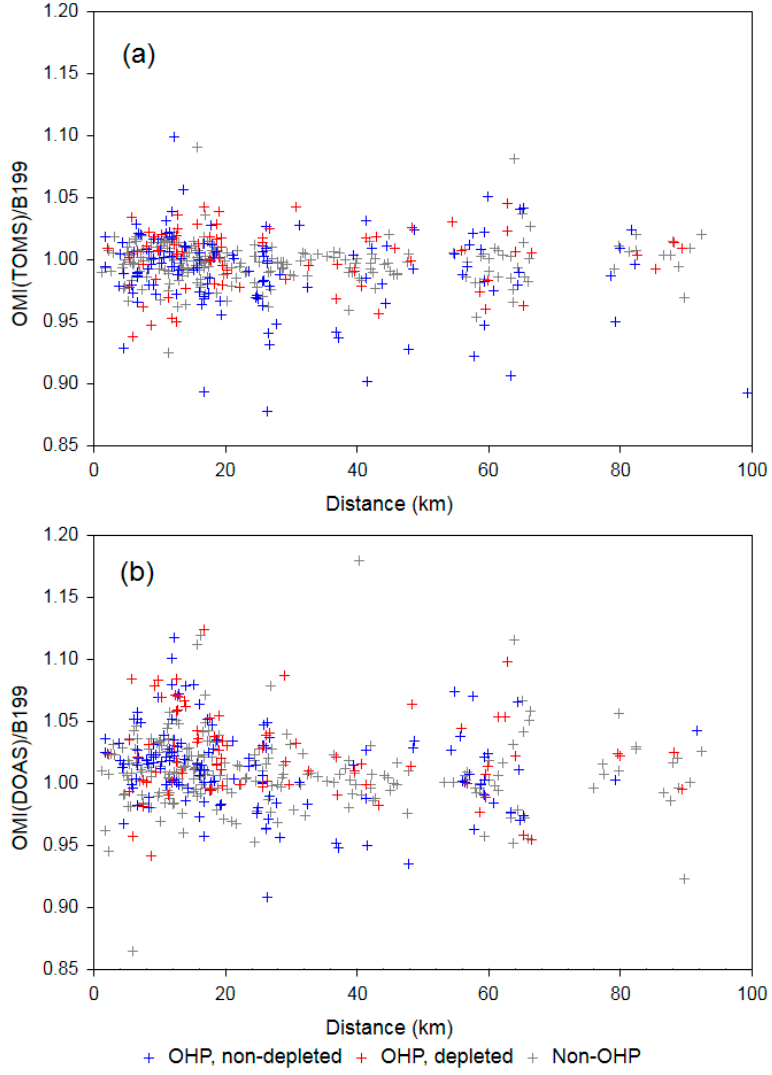
Figure A1. Relationship between ( a ) OMI(TOMS) and ( b ) OMI(DOAS) overpass distance from the Marambio Base and the ratio to the B199 ozone column records in 2011–2013; please note that none of these relationships was statistically significant (R 2 for OMI(TOMS) was 0.00, 0.03, and 0.00 for non-depleted, depleted, and non-OHP conditions, respectively; and for OMI(DOAS) it was 0.03, 0.03, and 0.00 for non-depleted, depleted, and non-OHP conditions, respectively).